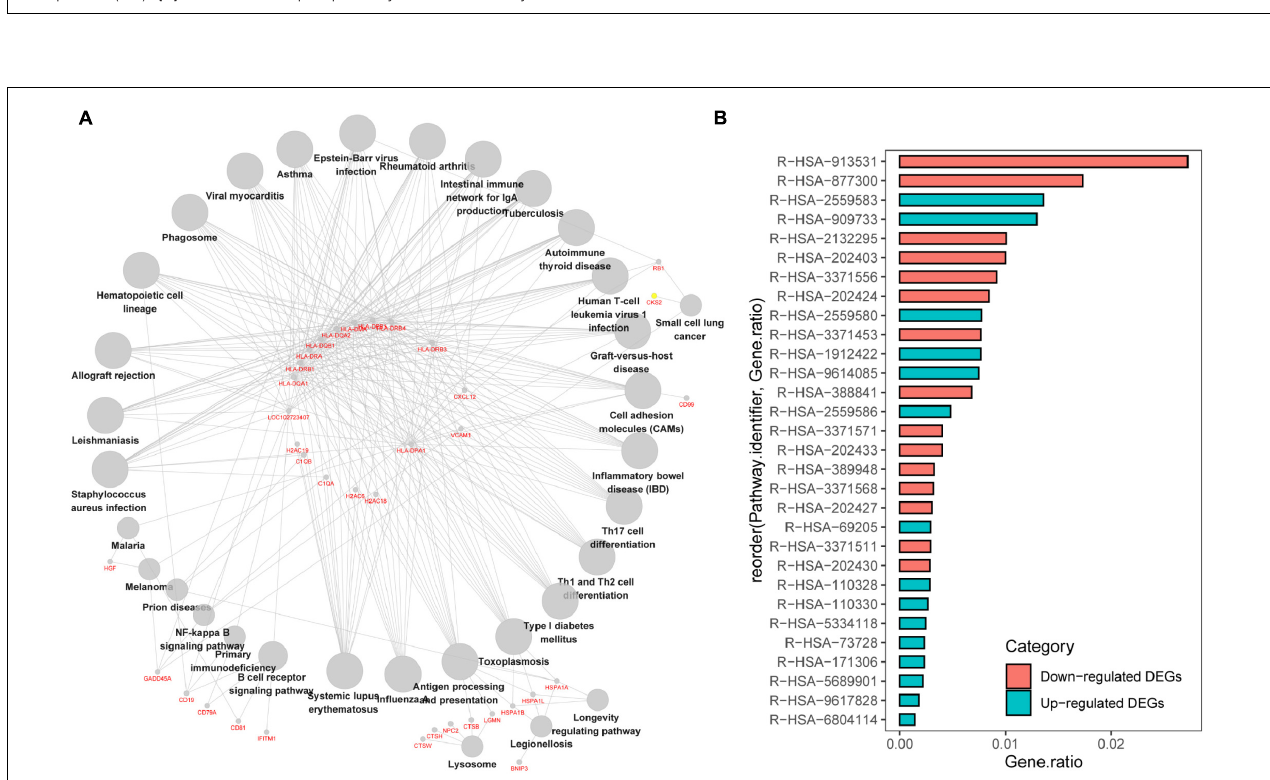
FIGURE 3 | KEGG pathway enrichment analysis of DEGs. (A) The correlation between DEGs and KEGG processes. (B) The Reactome pathway enrichment analyses of downregulated or upregulated DEGs.